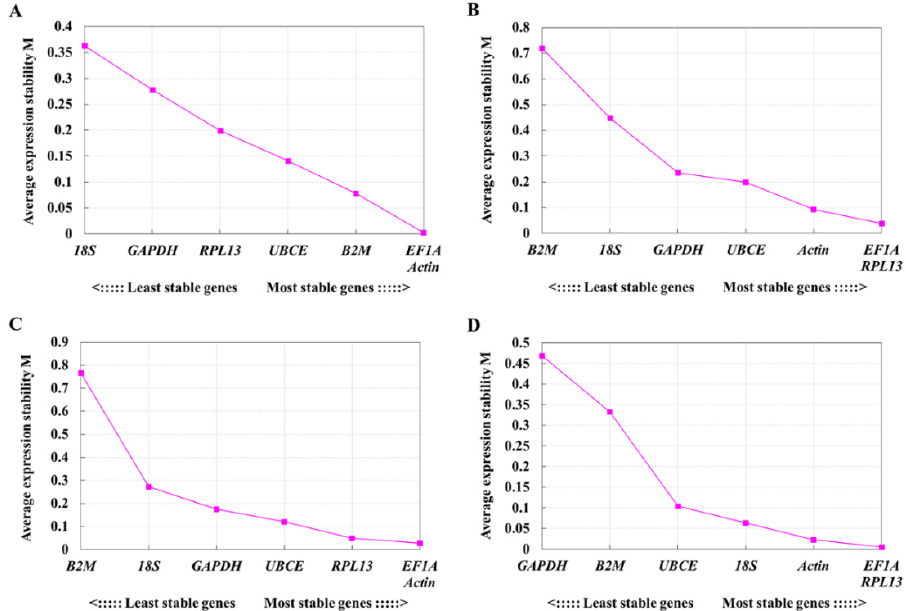
Figure 9. The expression stability of housekeeping gene candidates in GPHK cells under stimulation with Poly I:C for 2 ( A ), 4 ( B ), 8 ( C ) and 12 h ( D ) assessed by geNorm. According to the C t values presented by seven housekeeping gene candidate stimulations with Poly I:C or PBS, the average expression stability of housekeeping gene candidates can be evaluated M by geNorm, and not only can the M value not be more than 1.5, but the most reliable housekeeping genes have the most minimal M value as well.